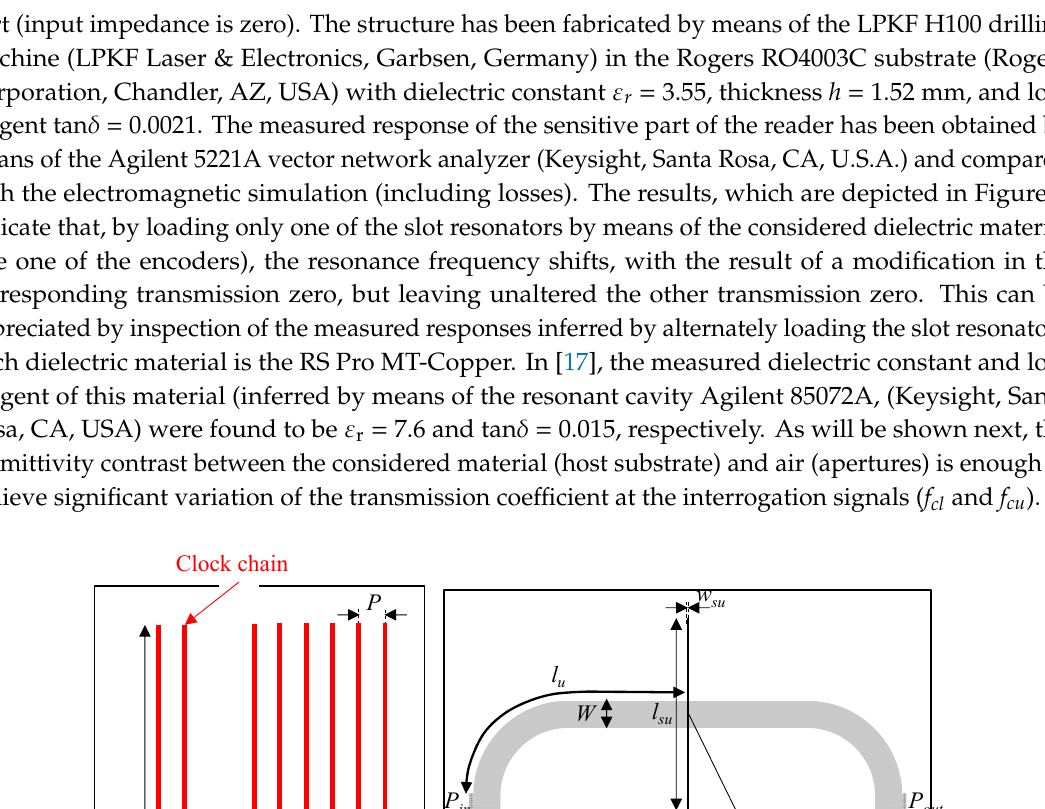
( b ) Figure 4. ( a ) Frequency response of the sensitive part of the bare reader inferred from lossless electromagnetic simulation and circuit simulation of Figure 2. The extracted element parameters are C su = 30.2 fF, C gu = 0.06 pF, C u = 0.40 pF, L u = 3.58 nH, C sl = 30.2 fF, C gl = 0.13 pF, C l = 1.26 pF, and L l = 2.02 nH. Such simulations have been inferred by means of the Keysight ADS software; ( b ) Current distribution of the sensitive part of the reader at the fundamental resonance frequency of the slot resonator of the upper and lower branch.